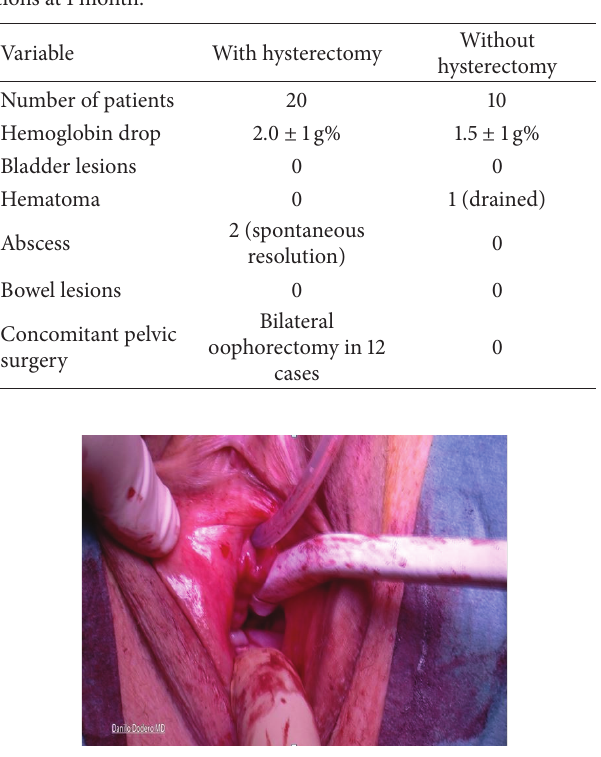
Table 2: List of operative parameters and postoperative complica- tions at 1 month.